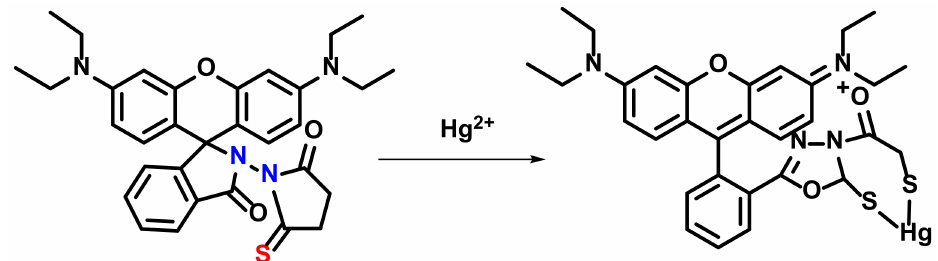
Figure 7. Proposed sensing mechanism of Hg 2+ ion through Hg-S bond formation from fluorescein-based thiosemicarbazide group (re-drawn from [22]).